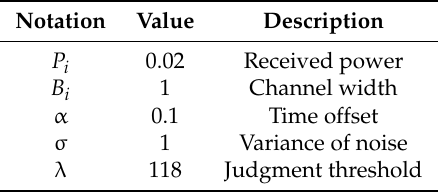
Figure 4. An example of the distribution of the channel energy. The entire spectrum bandwidth to be perceived was 100 HZ, which is in the frequency range of (0; 100) MHz. The whole spectrum was divided into 100 channels. Table 1. Values of the experimental